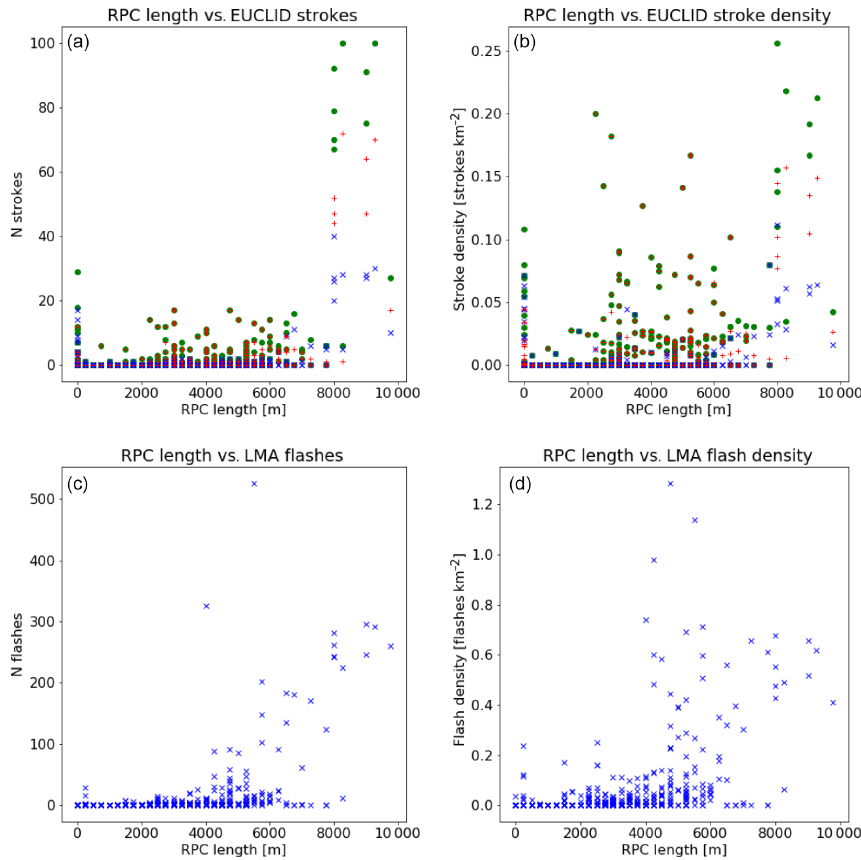
Figure 8. Scatter plot of RPC height versus (a, c) number of flashes within the TRT cell detected. (b, d) Density with respect to cell area. (a, b) EUCLID CG strokes. Blue crosses: CG + strokes; red crosses: CG − strokes; green dots: total lightning. (c, d) LMA first sources.